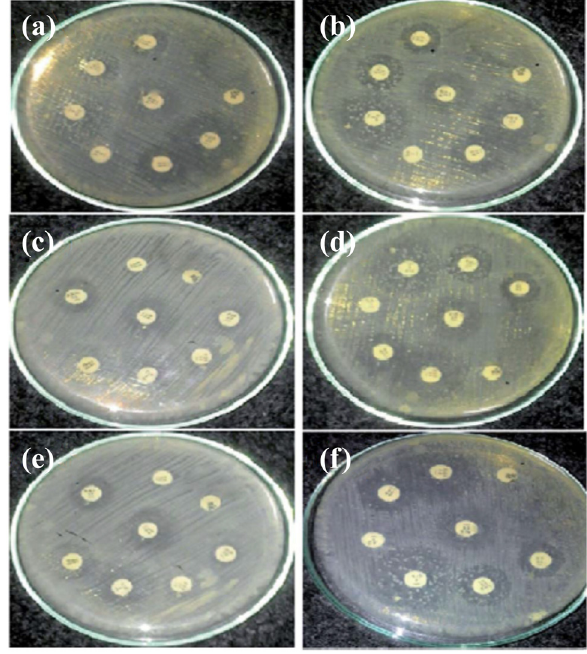
Figure 11: Kirby disk di ff usion antimicrobial studies for SA micro - organisms. NE ( a – c ) and NOT ( d – f ) [ 60 ] . Copyright © 2019; Royal Society of